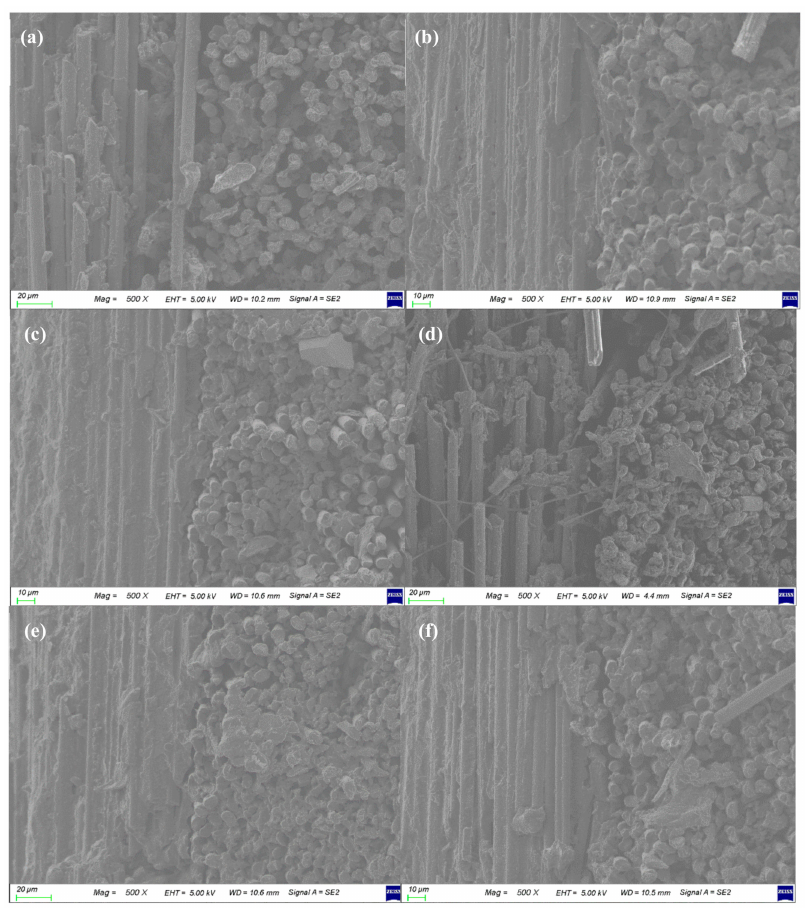
Figure 10. SEM images of cross-sectional surfaces of the Carbon/APA at different molding conditions;